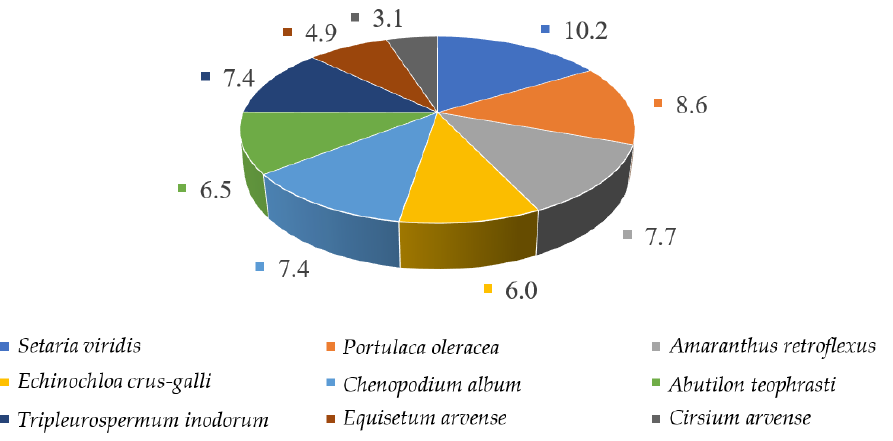
Figure 1. Floral composition of weeds (%) at the beginning of the